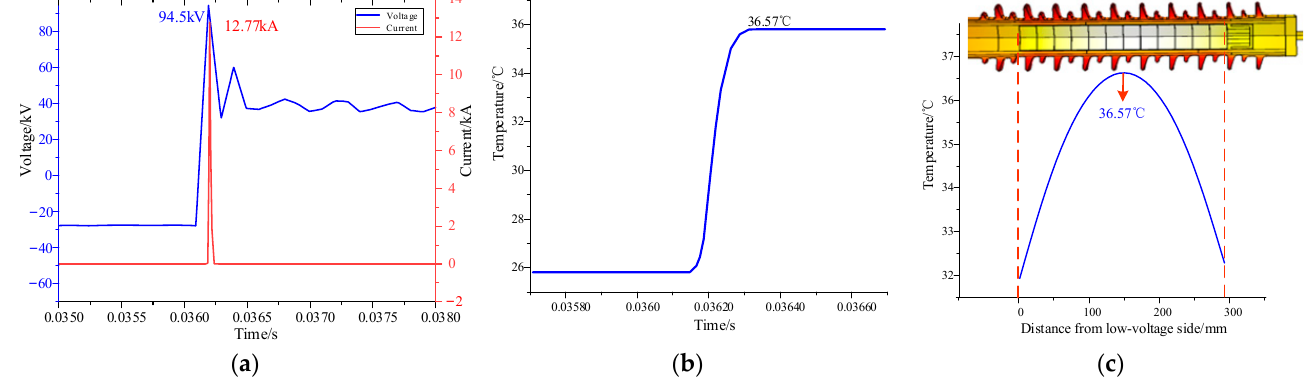
Figure 16. The current and temperature distributions of the arrester. ( a ) Passing section overvolt- age and current. ( b ) Temperature variation of the arrester. ( c ) Temperature distribution of the valve column.